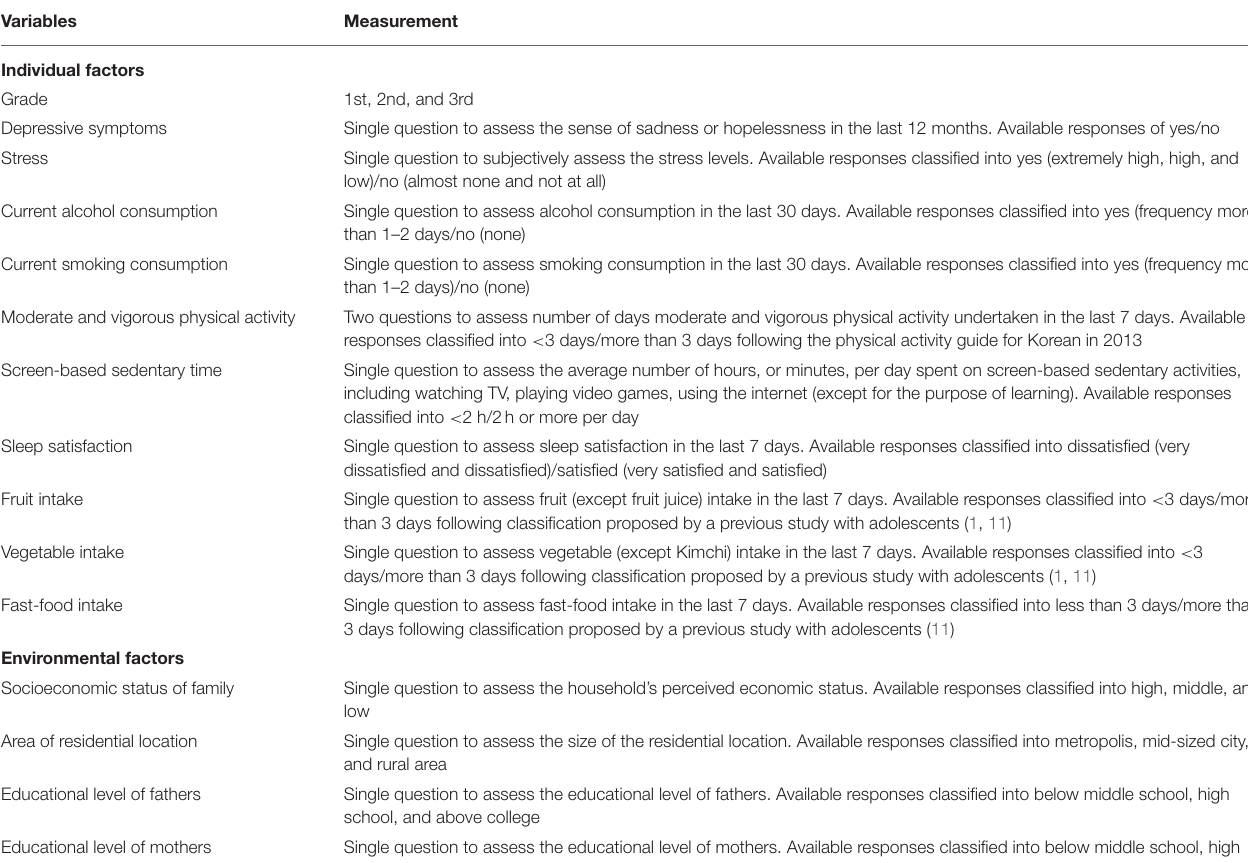
TABLE 1 | Measurement of individual and environmental